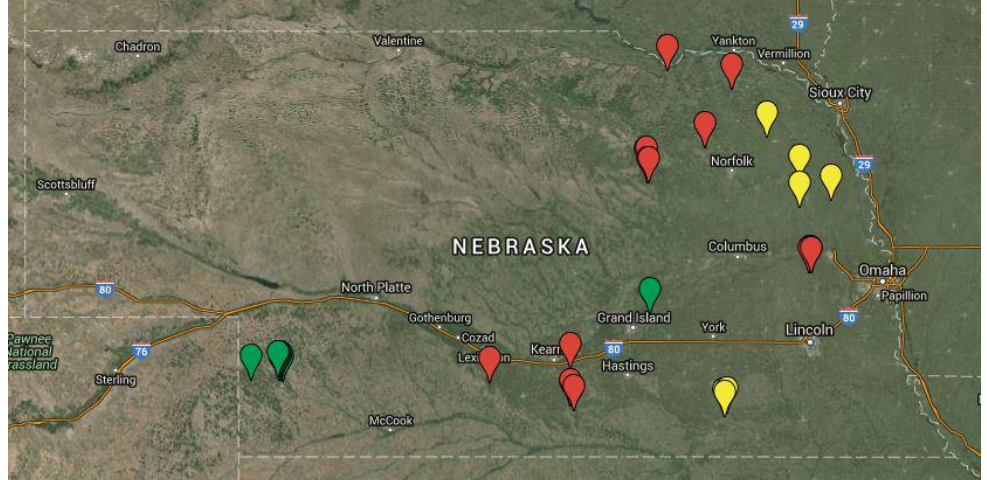
† Observed rainfall during growing season; Rodebud complex: Rosebud-Canyon, Blanche, Duda-Tassel; Valent complex: Valent, Duda-Tassel and Jayem; ‡ Till = tillage system including conventional tillage consisting of disk or chisel plow tillage (CT) or no-till (NT); Jayem Complex: Jayem, Ascalon and Valent. Note: Row spacing was 76.2 cm except for 50.8 cm at site 5 and 18, 91.4 cm at site 19, and 38.1 cm” at site 26. Agronomy 2020 , 10 , x FOR PEER REVIEW